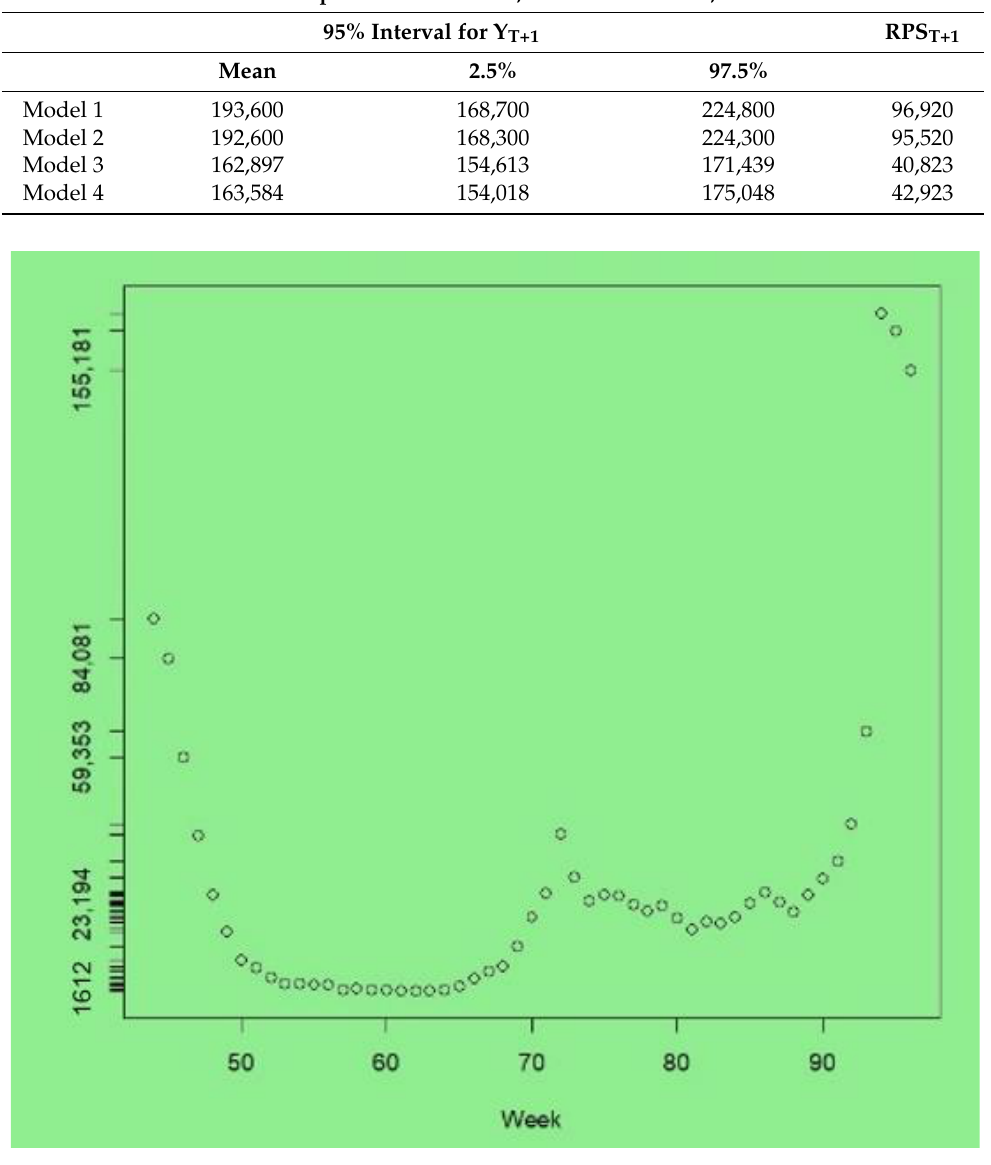
Figure 1. COVID cases, London, weeks 44 – 96.